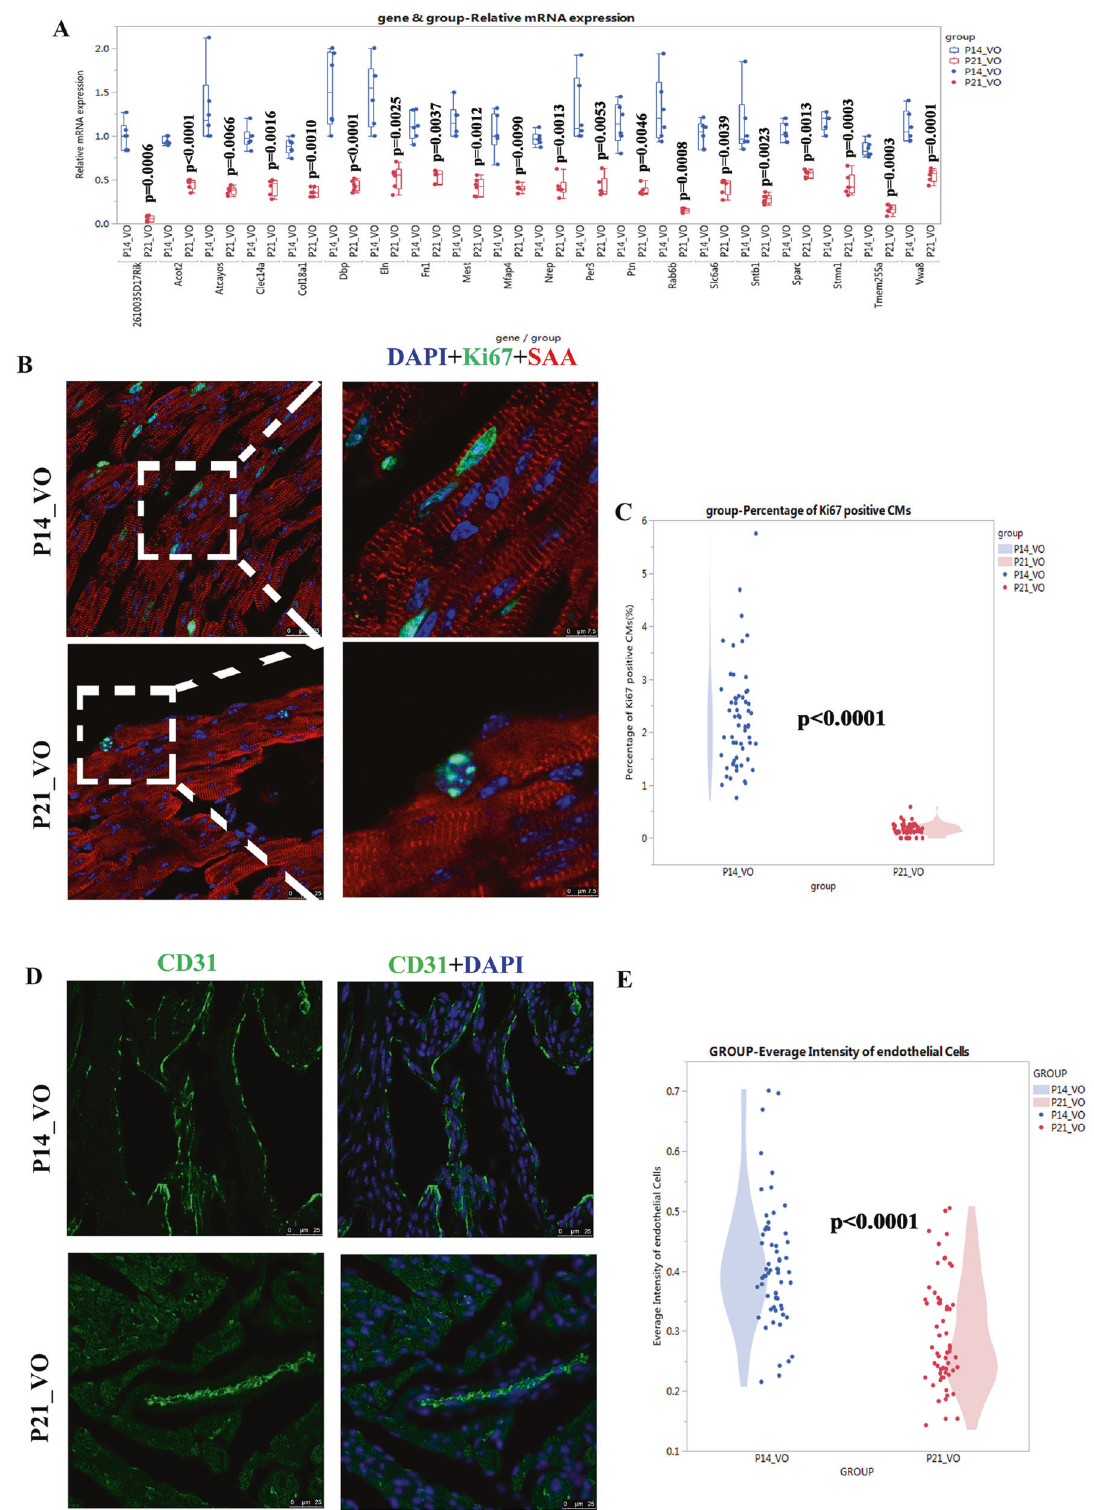
Fig. 7 Veri fi cation of downregulated processes during VO-in fl uenced postnatal RV development. A The 20 genes manifesting the greatest fold changes of the downregulated transcriptome. B Representative Ki67-positive cardiomyocytes in the VO group. C Quanti fi cation of Ki67- positive cardiomyocytes in the VO group. ( N = 60 slides from six mice). D Representative CD31-positive cells in the VO group. E Quanti fi cation of the average intensity of endothelial cells ( N = 60 slides from six